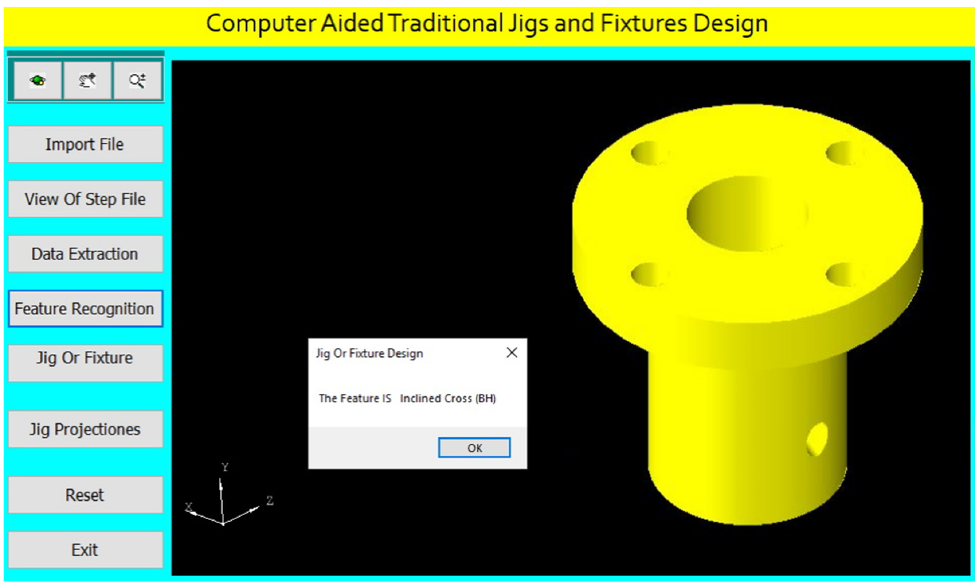
Figure 31. Automatic feature recognition of an inclined cross blind hole. The program checks the inclined cross blind hole of (4 mm) diameter for identifying the suitable guide bush.